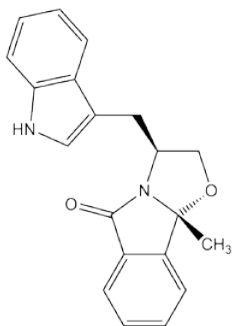
Figure 4. SLMP53-1 compound that targets DNA-binding class mutants of p53.